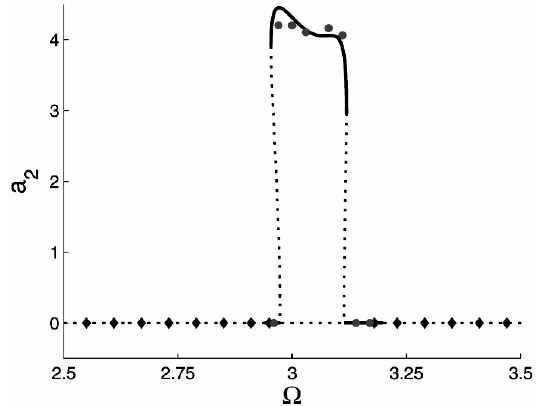
Fig. 9. Analytical and numerical results for the system with control. Analytical solution: solid line – stable solution, dotted line – unstable solution. Numerical results: circles – amplitude of periodic motion, diamonds – maximum and minimum amplitude of positive part of en- velope of quasi-periodic motion; x 0 = 0.01, α 2 = 0.106.